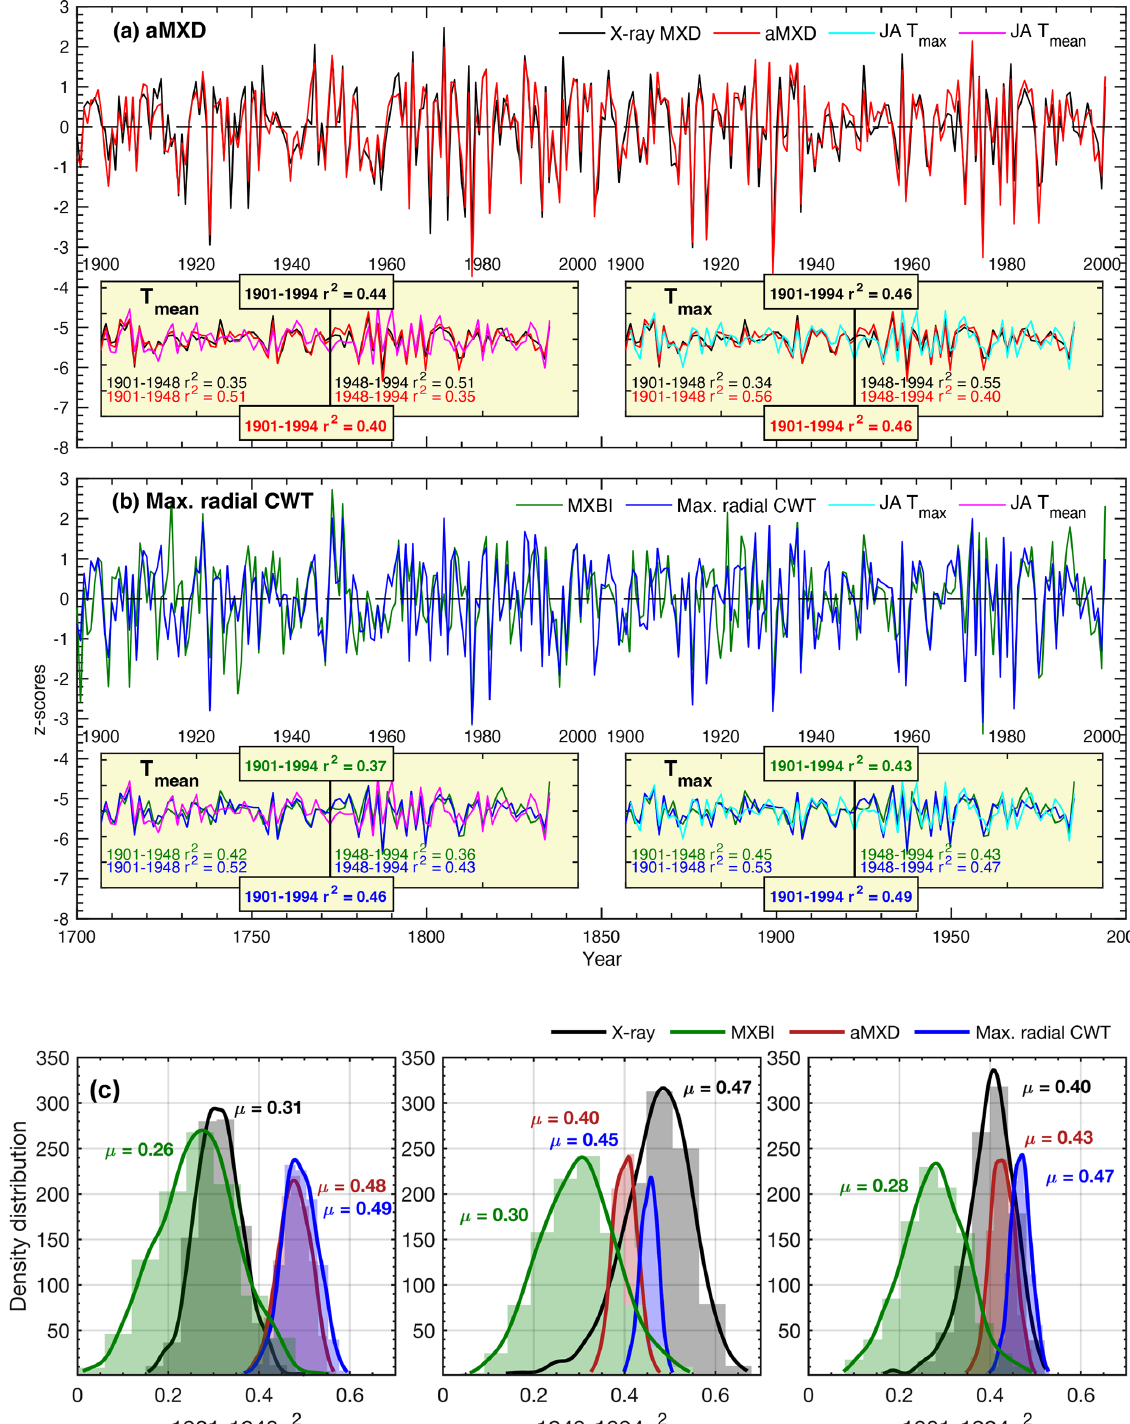
Figure 6. (a, b) Full (1901–1994) and split-period (1901–1948, 1949–1994) calibration statistics for the Max. radial CWT (blue line), aMXD (red line), X-ray MXD (black line) and MXBI (green line) chronologies against July–August mean and maximum CRU TS temperatures. Time series in the figures show non-detrended mean chronologies, z -scored over the instrumental 1901–1994 period. (c) The density distri- bution and its mean ( µ ) of r 2 values obtained from 1000 calibration trials where parameter chronologies are built from 10 series randomly drawn without replacement from the sample cohort. The resampling trials are based on detrended climate and tree-ring data. Calibrations are performed against July–August maximum temperatures.